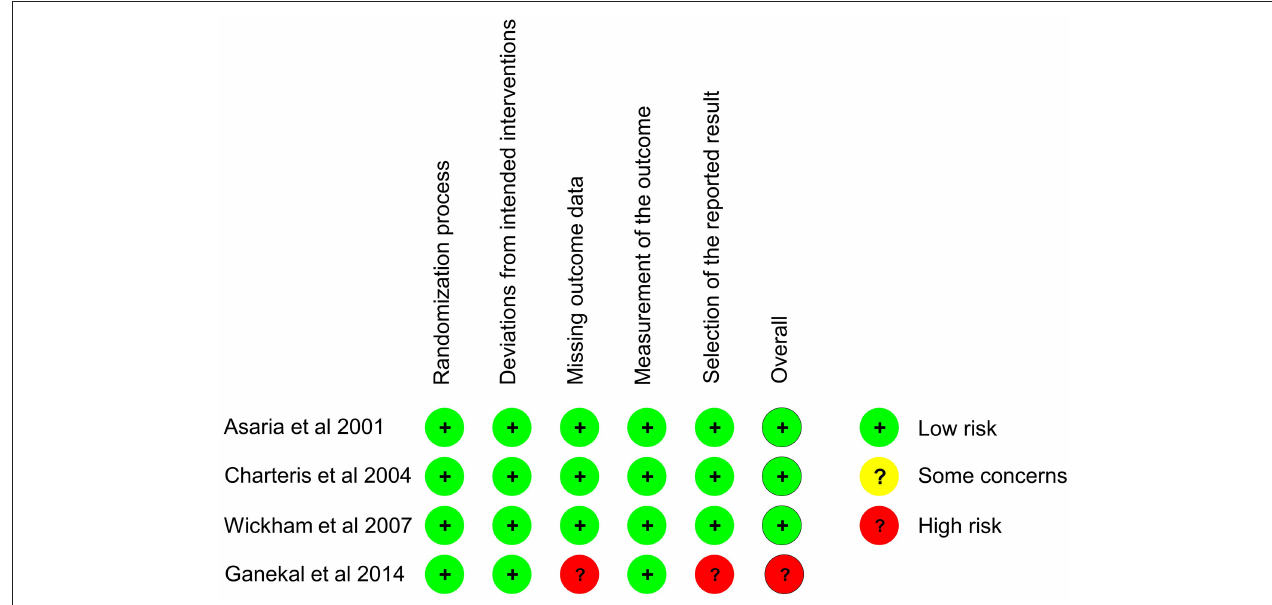
FIGURE 2 | Summary of risk of bias assessment for RCTs using RoB 2.